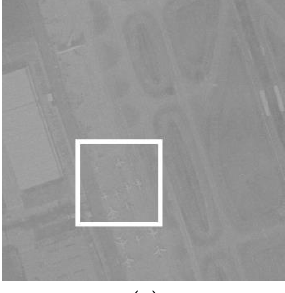
Figure 7. The unsatisfactory detection result: ( a ) input RSI (partial area marked by the white box), ( b ) partially enlarged RSIs with ground truth (represented by the yellow boxes), ( c ) YOLOv5 results (represented by the blue boxes), and ( d ) L-SNR-YOLO results (represented by the red boxes).